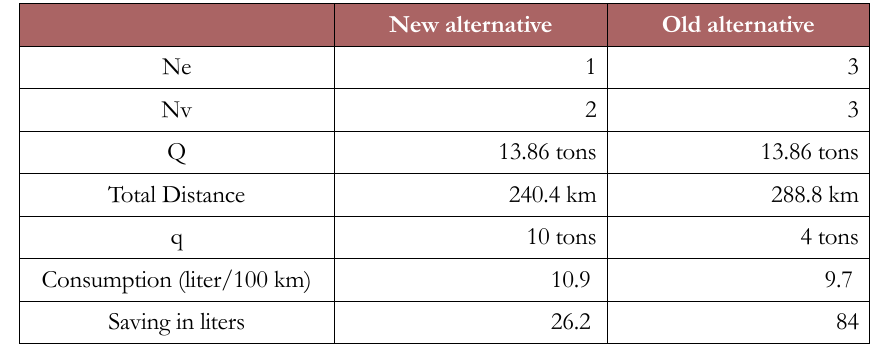
Table 14. Operational